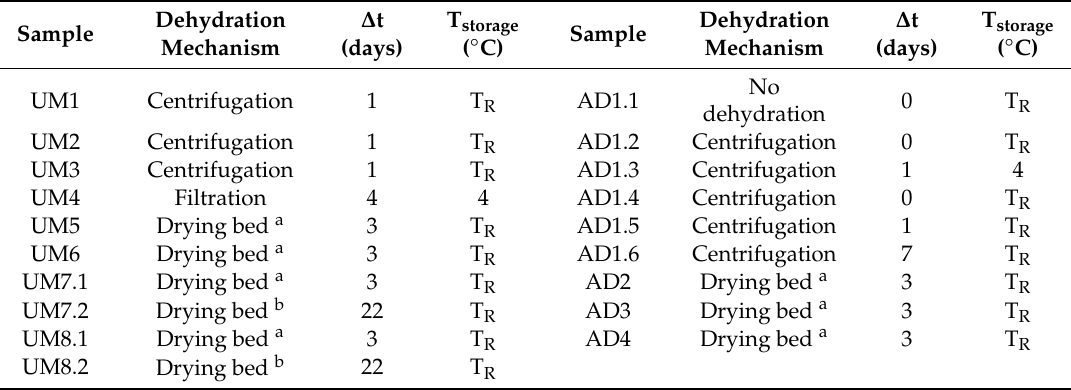
Table 1. Characteristics of the samples and conditions of the